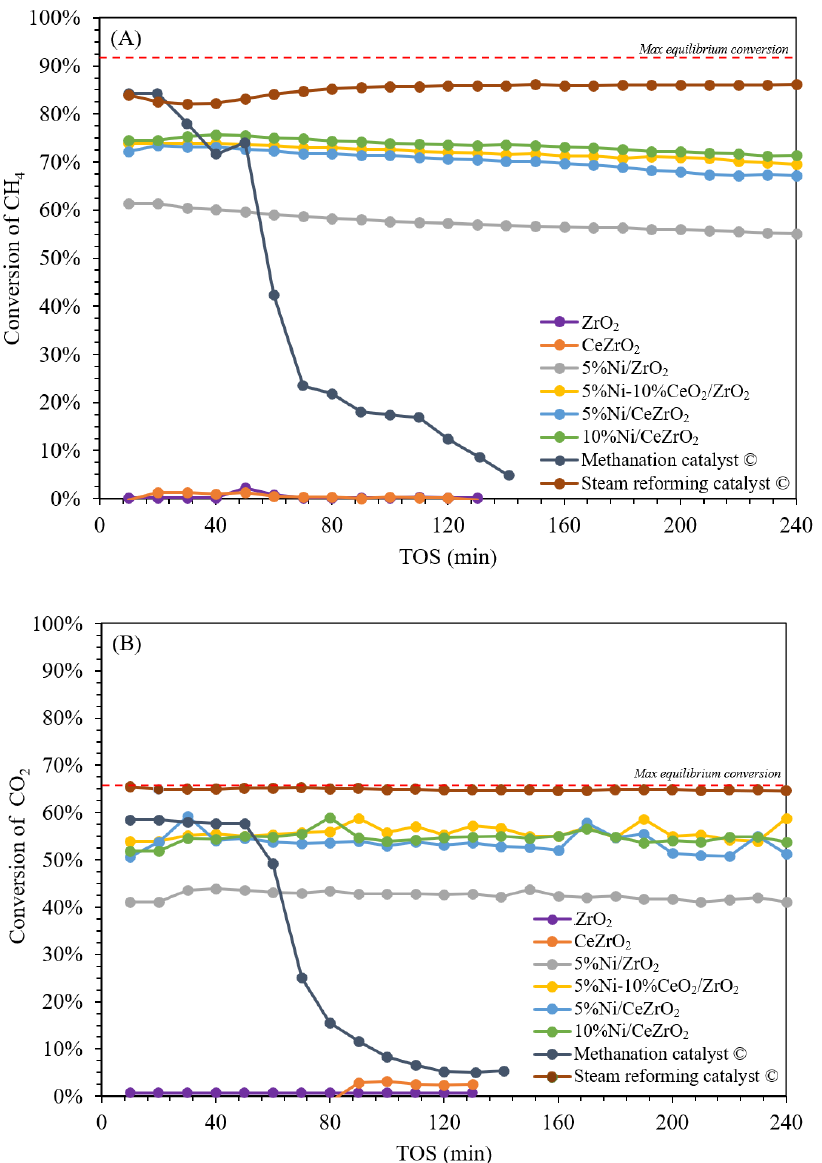
Figure 6. Conversion of reactant on a ceria-zirconia-supported nickel catalyst: ( A ) CH 4 and ( B ) CO 2 (temperature of 700 °C, atmospheric pressure, WHSV 60,000 mL g −1 h −1 ).